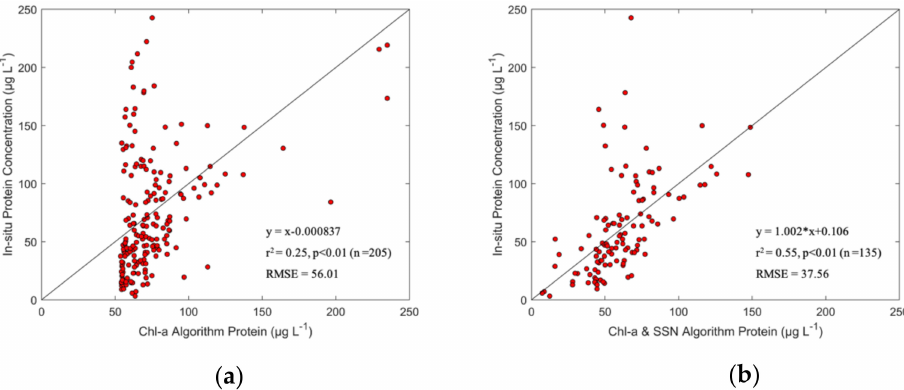
Figure 3. The validation of a regional algorithm for the phytoplankton protein concentration of phytoplankton. The linear relationship between field-measured and algorithm-derived protein concentrations of phytoplankton is ( a ) based on chlorophyll-a concentrations and ( b ) based on chlorophyll-a and sea surface nitrate concentrations. Black solid lines represent the 1:1 line. Table 2. The result of multilinear regression analysis for the protein concentration of phytoplankton in the EJS.